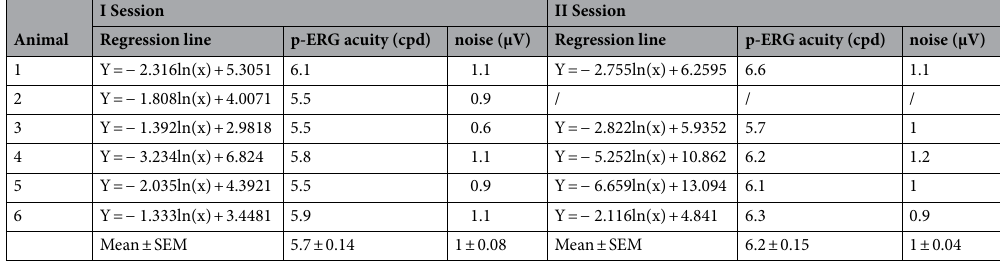
Table 1. p-ERG acuities calculated during both recording sessions and corresponding regression line formulas.